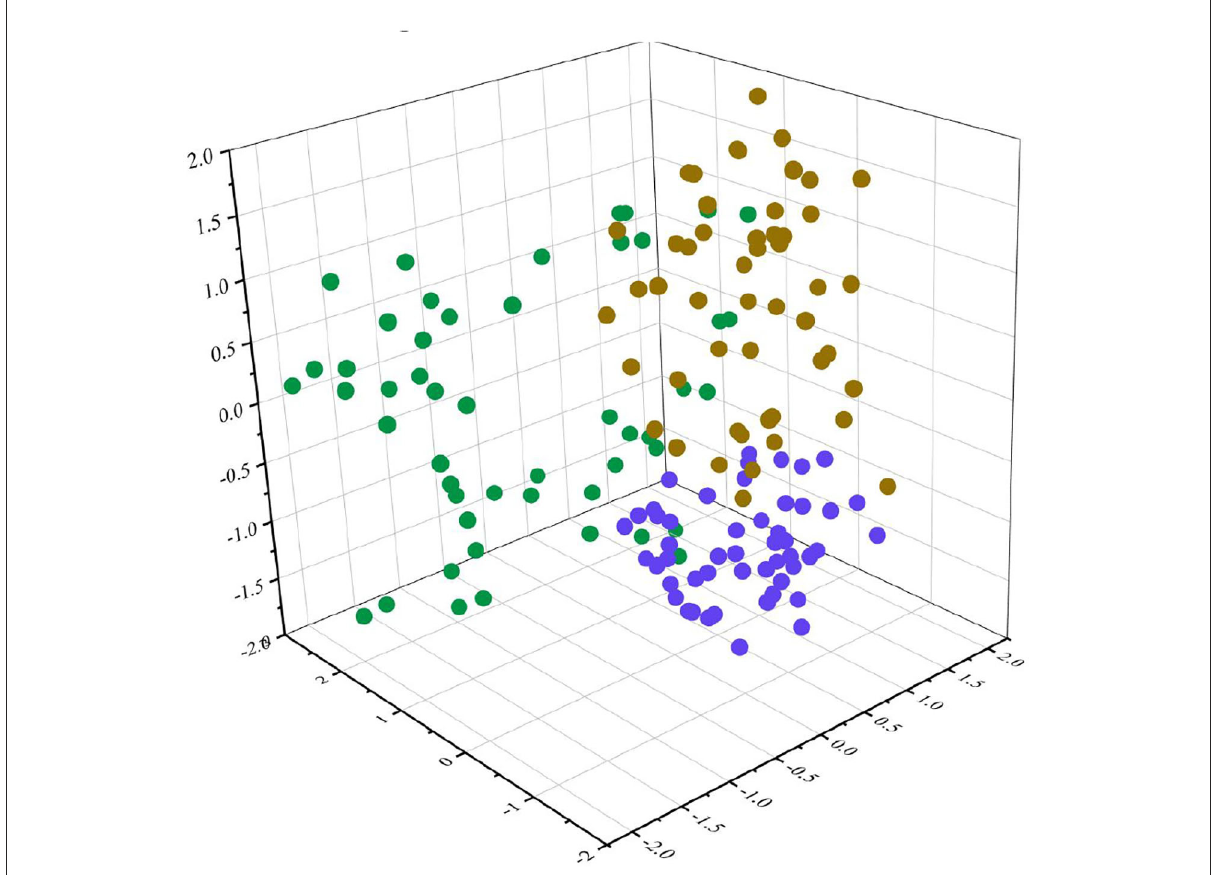
FIGURE4 Fuzzy clustering results.